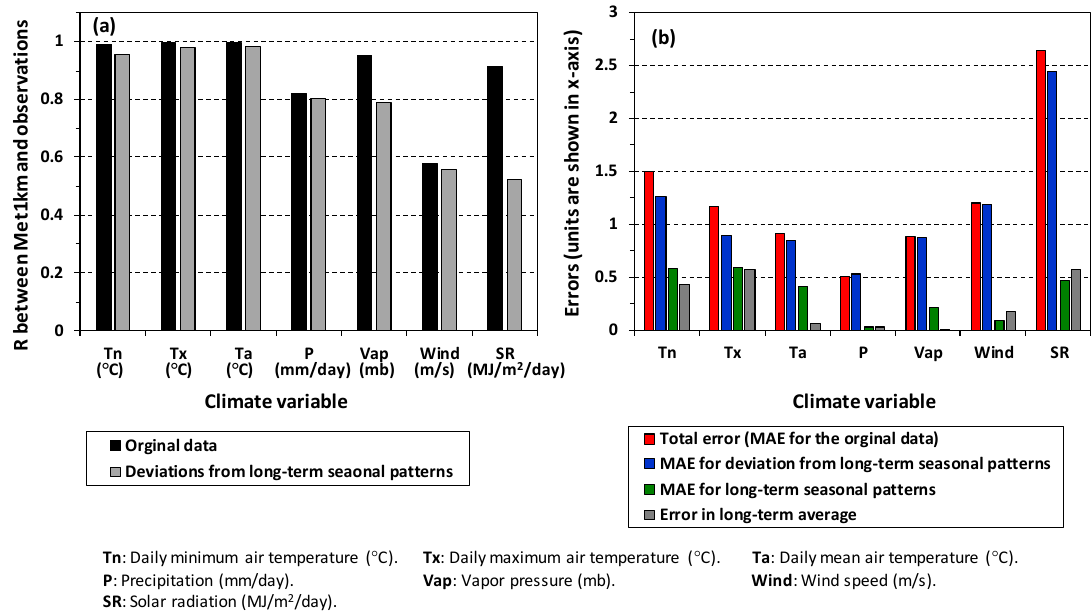
Figure 6. ( a ) Correlation coefficients (R) between Met1km and measurements at the Yellowknife airport climate station, and ( b ) the total error and the three error components of Met1km calculated by comparing to the observations at the climate station. The daily observations for precipitation are from 1948 to 2016, and other observations are from 1953 to 2005.